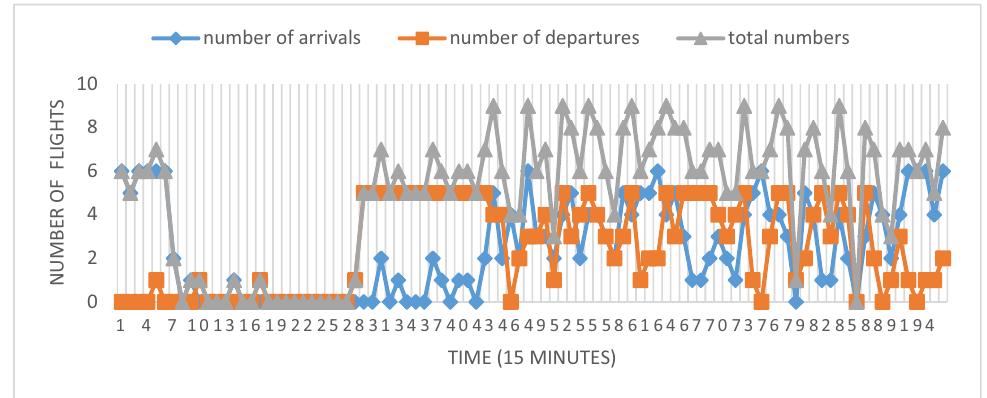
Figure 8: Arrival and departure fl ight slot distribution in every 15 min in the optimized fl ight schedule by Scheme 2 when δ 1 =